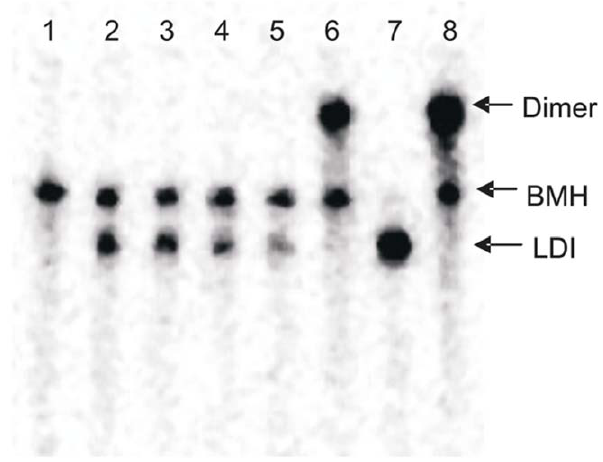
Figure 10. Mobility of HIV-1 leader RNA (447nts) in different buffers. The RNA transcripts were incubated in different buffer conditions and were analyzed on 4% non-denaturing TBE gel. Lane 1: Formamide buffer, Lane 2: Tris-Cl buffer, Lane 3: TN buffer, Lane 4: TN buffer with 0.1 mM MgCl 2 , Lane 5: TN buffer with 1.0 mM MgCl 2 , Lane 6: TN buffer with 5 mM MgCl 2 , Lane 7: TEN buffer and Lane 8: